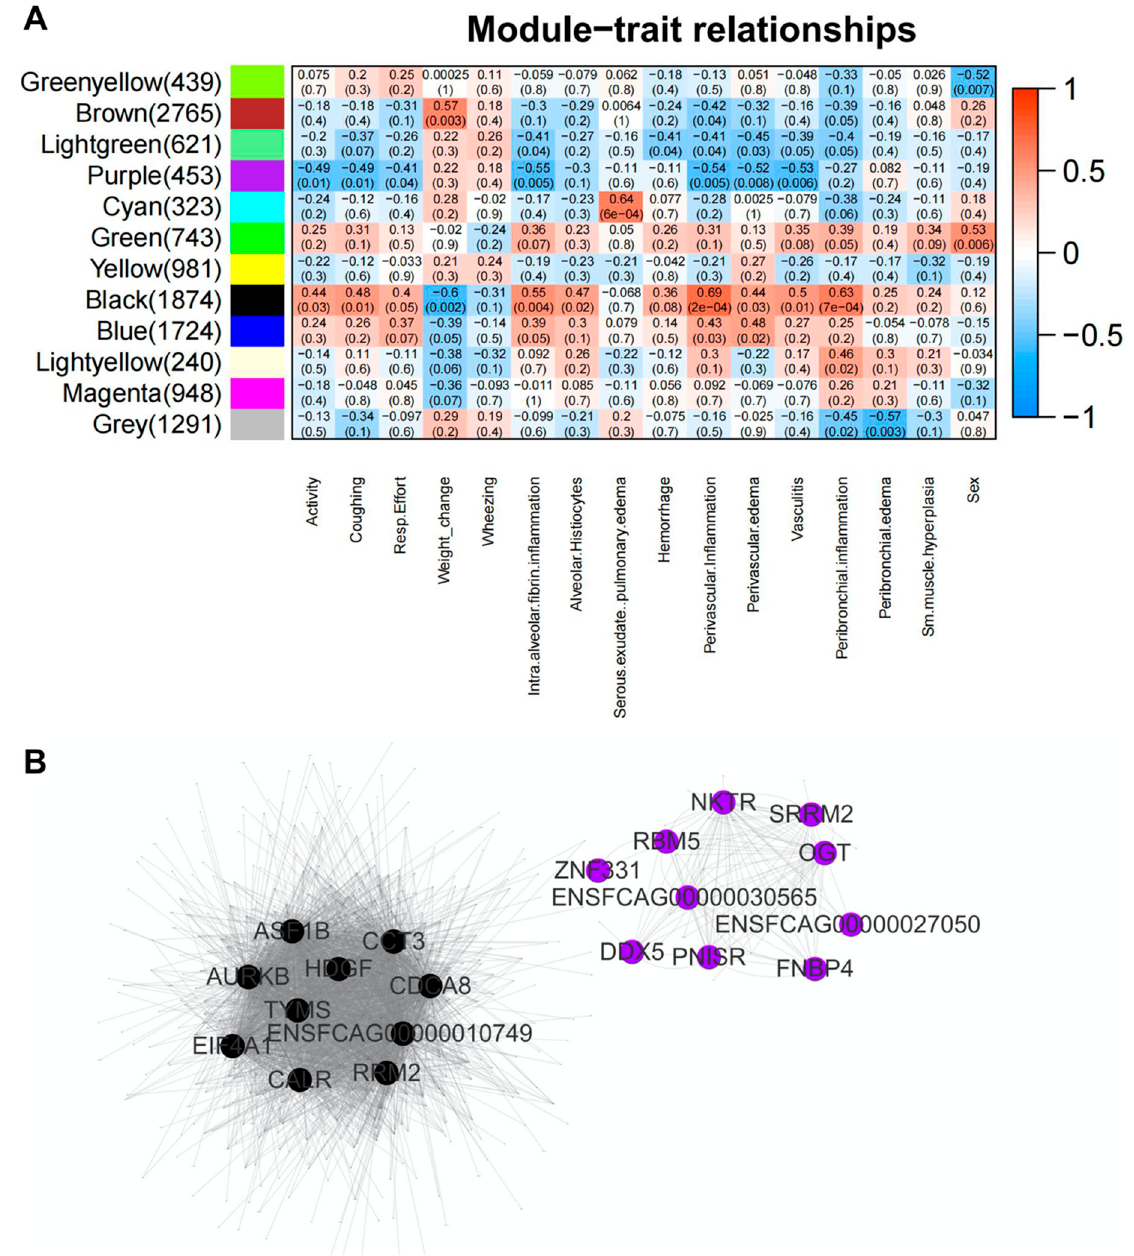
Figure 8. Weighted correlation network analysis (WGCNA) on lung RNA-Seq data obtained from SARS-CoV-2 infected domestic cats. ( A ) Relationships of consensus module eigengenes and histopathology and clinical traits. Each row in the figure corresponds to a consensus module, and each column to a histopathological trait. Numbers in the cells report the correlations of the corresponding module eigengenes and traits, with the p -values printed below the correlations in parentheses. The cell is color coded by correlation according to the color legend. ( B ) Identification of hub genes based on intra-modular connectivity in black and purple modules.